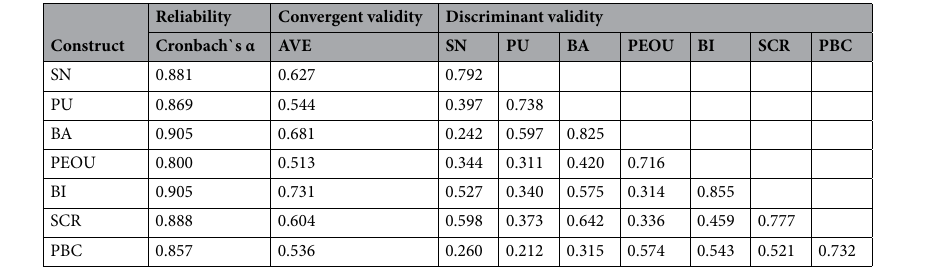
Table 2. Assessment of reliability and